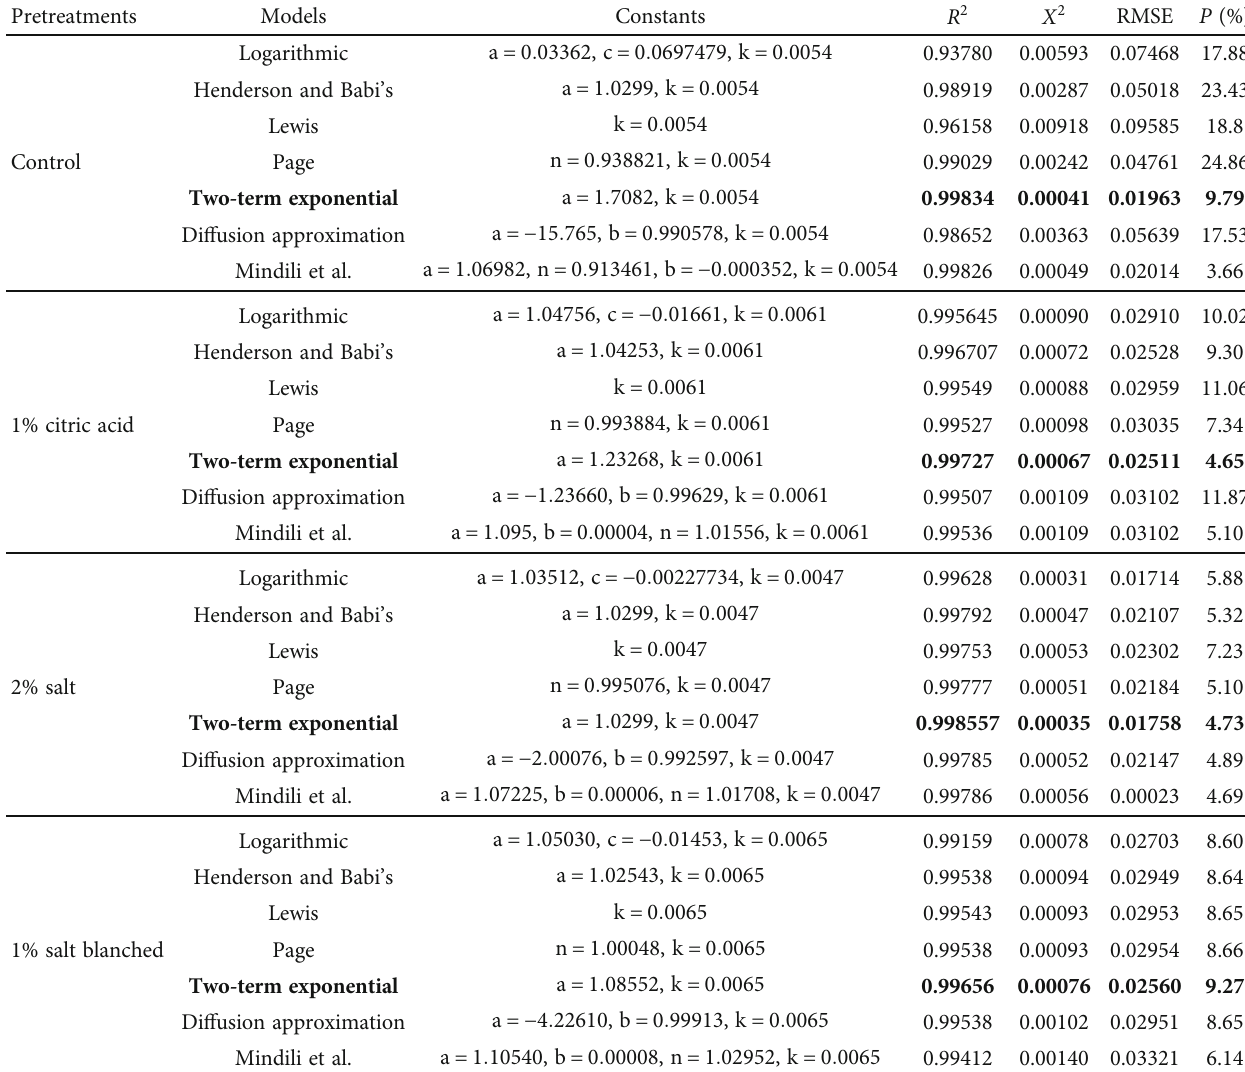
Table 5: Curve fi tting criteria for the various mathematical models and parameters for pumpkin slice dried at zone I.